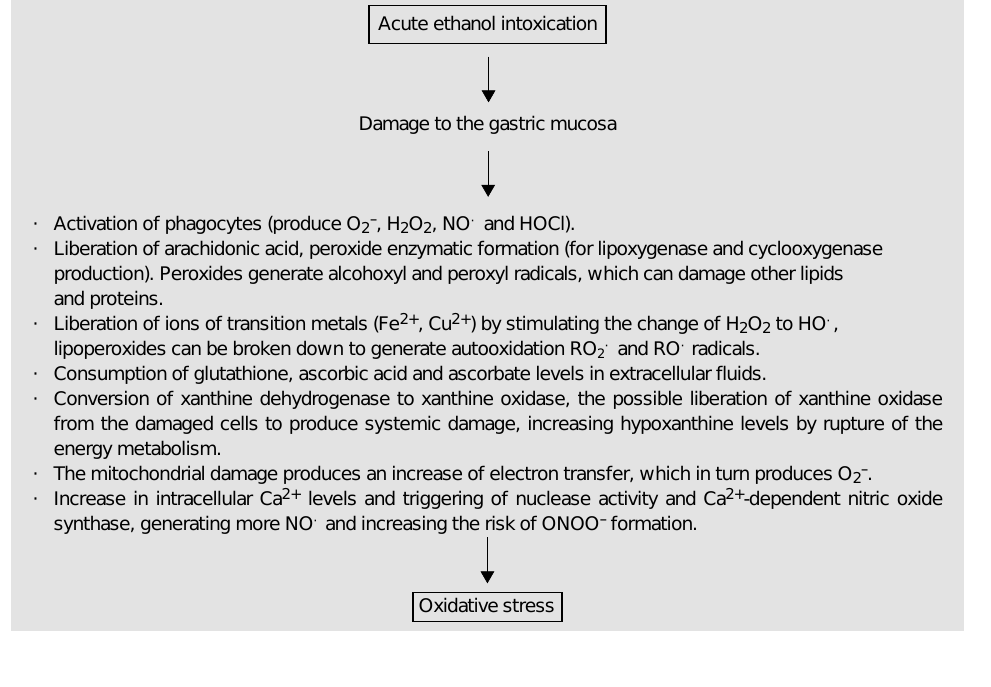
Figure 1. Oxidative stress and physiological consequences of acute ethanol intoxication in gas- tric mucosa.